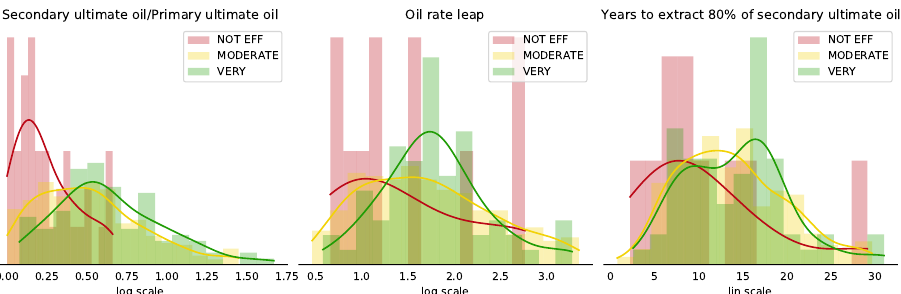
Figure 6. Histogram plot of target metrics for very effective (green), moderate effective (yellow), and not effective (red) waterflooding